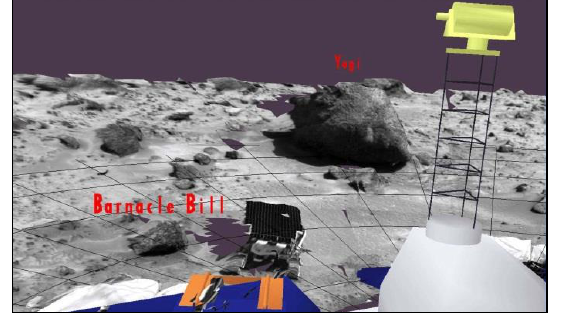
Fig. 6. Virtual Reality Simulation for a Mars' Rover [9].